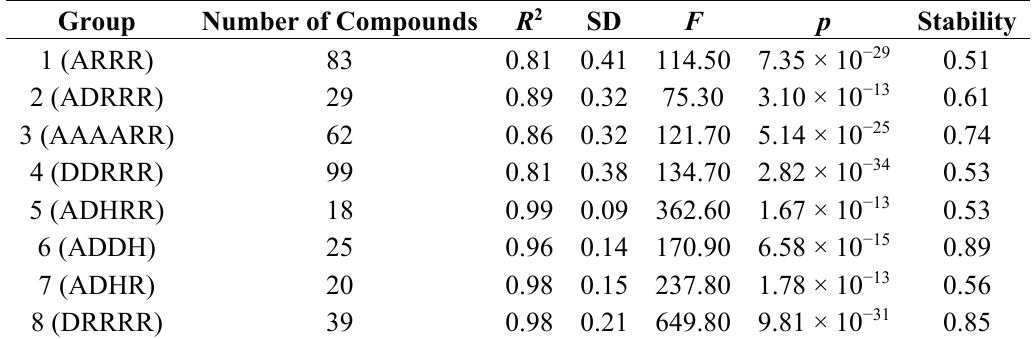
Figure 1. The flowchart to develop the combinatorial pharmacophore-based three-dimensional quantitative structure-activity relationship (3D-QSAR) model. Table 1. Statistic parameters of the combinatorial QSAR model for the training set.